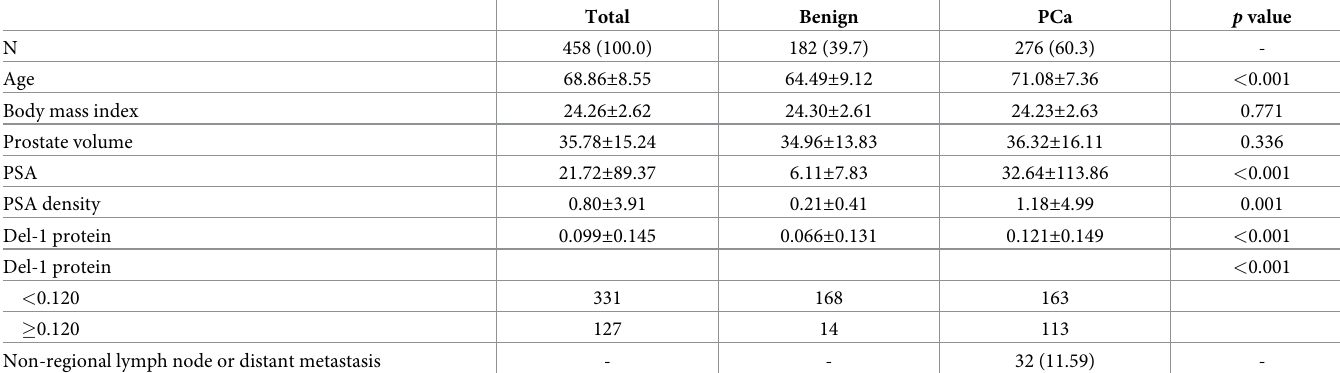
Table 1. Basic characteristics of the patients (benign versus prostate cancer).